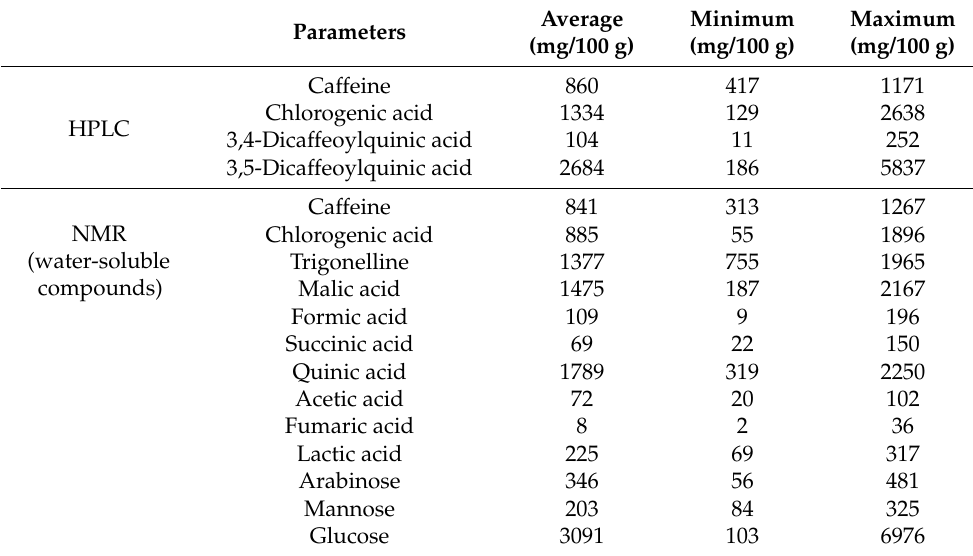
Table 1. Determination of the organic compounds in the coffee flower samples (n = 35).